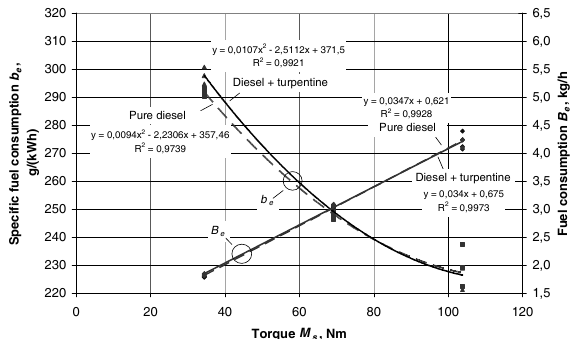
Fig 1. Dependence of fuel consumption on the engine torque for run at speed of 1 700 min –1 Both of these cases are presented in Fig 2. Both graphs are highly similar. They show the fuel consump- tion of 1Z engine for its run at rotational speed of 2 200 min –1 . It is seen that both fuel consumption B e and specific fuel consumption b differ imperceptibly, e however they are slightly higher for engine, operating with pure diesel fuel. The greatest difference is at mod- erate loadings but it does not exceed 2 %